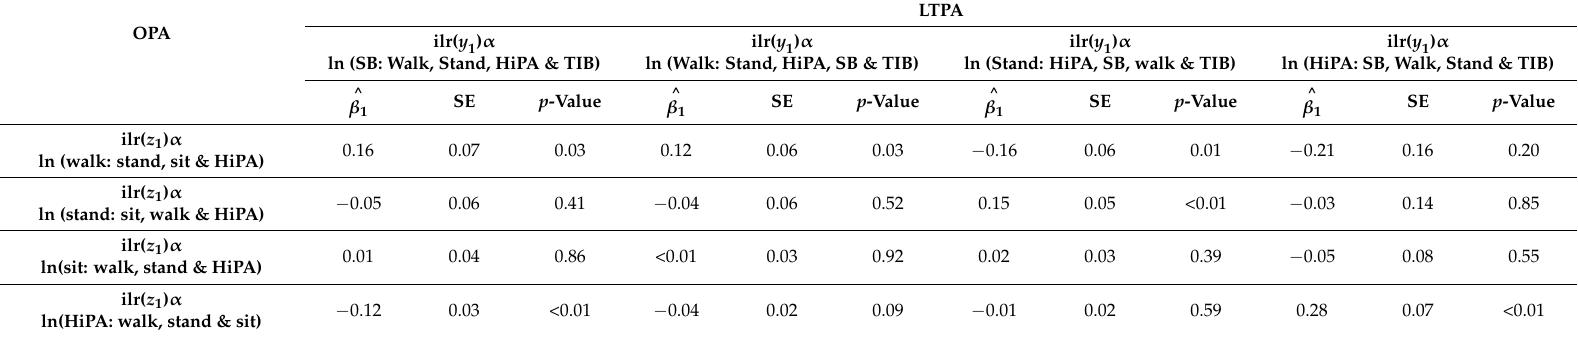
Table 6. Compositional analysis of the association between ilr-coordinates of OPA and LTPA subcompositions among women (N = 400).